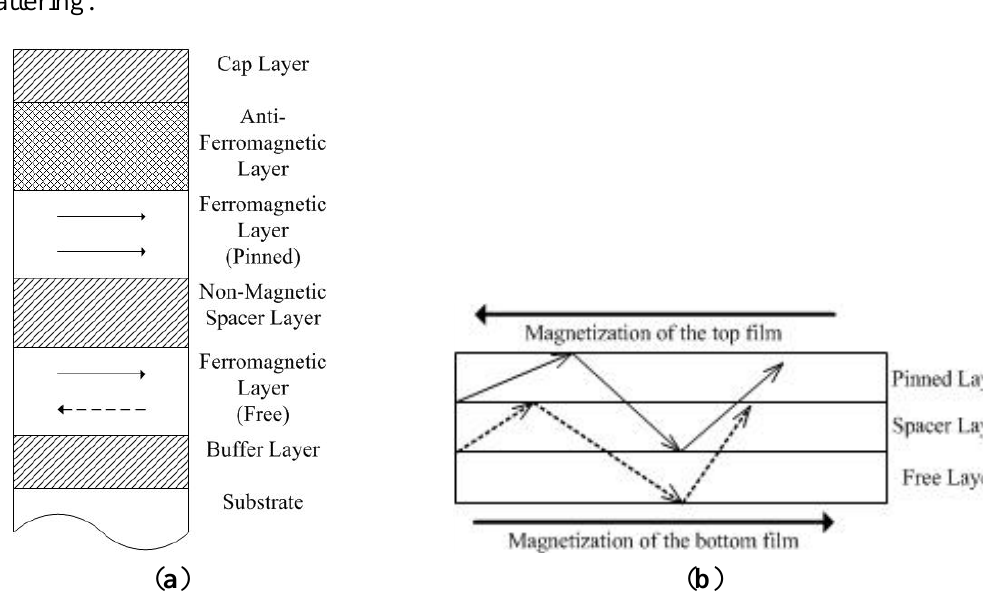
Figure 1. ( a ) Schematic cross-section of a GMR layered structure; ( b ) limited electron path due to